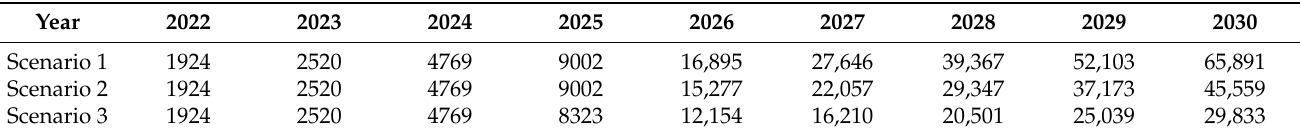
Table 1. Number of Electric Vehicles in Campinas: Projection Scenarios.